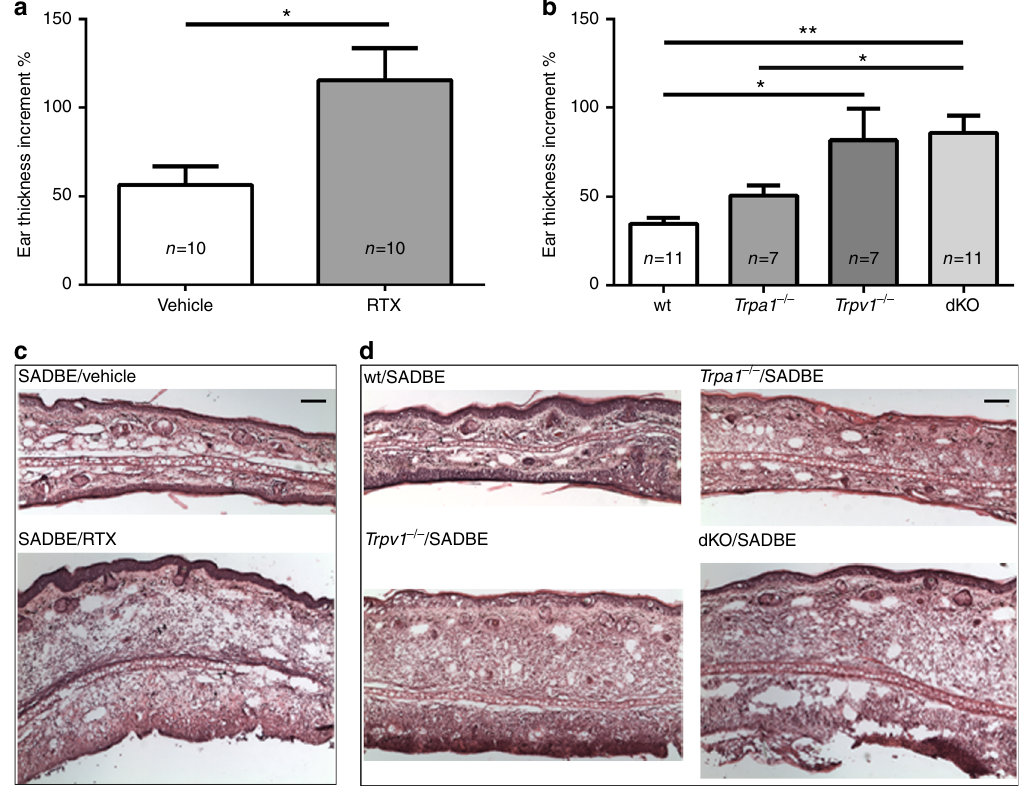
Fig. 6 TRPV1-expressing sensory nerves protect against skin in fl ammation. a Bar charts illustrate ear thickness increment in wt mice pre-treated with either vehicle or RTX. Data are presented as mean ± SEM. Asterisks indicate statistical signi fi cance. * p < 0.05, Student ’ s t -test; b Bar charts illustrate ear thickness increment in wt, Trpa1 − / − , Trpv1 − / − and Trpa1 − / − / Trpv1 − / − dKO mice. Data are presented as mean ± SEM. Asterisks indicate statistical signi fi cance. * p < 0.05; ** p < 0.01, ANOVA; c Representative H&E staining of ear skin sections from wt mice, pre-treated with vehicle or RTX; Scale bar , 100 µ m; d Representative H&E staining of ear skin sections from wt, Trpa1 − / − , Trpv1 − / − and Trpa1 − / − / Trpv1 − / − dKO mice. Scale bar , 100 µ m